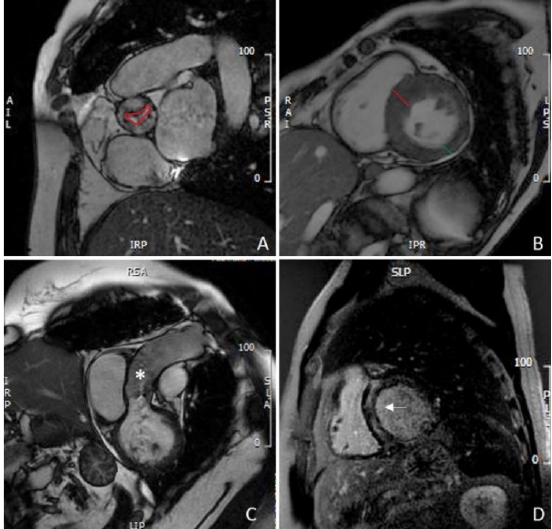
Figure 1. CMR evaluation of aortic stenosis: ( A ) planimetry of aortic valve (red line); ( B ) measurement of IVS (red line) and PW thickening (green line), showing asymmetric hypertrophy of the IVS; ( C ) assessment of thoracic aorta (asterisk); ( D ) mid-wall LGE of the IVS. CMR: cardiovascular magnetic resonance; IVS: interventricular septum; PW: left ventricle posterolateral wall; LGE: late gadolinium